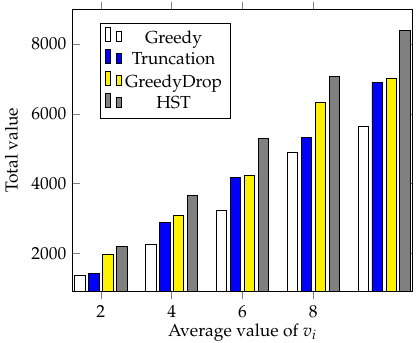
Figure 8. The effect of different average values of v i for FIFO